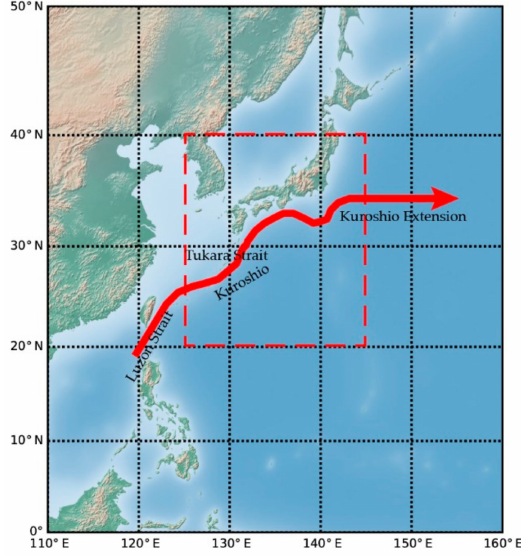
Figure 1. The study area is identified by a red dotted rectangle, and the solid red line represents the Kuroshio current. The Kuroshio passes through the Luzon Strait, and the majority flows northward along the east coast of Taiwan into the East China Sea. Then it flows out of the East China Sea from the Tukara Strait, and finally flows eastward offshore near 35 ◦ N, becoming the Kuroshio